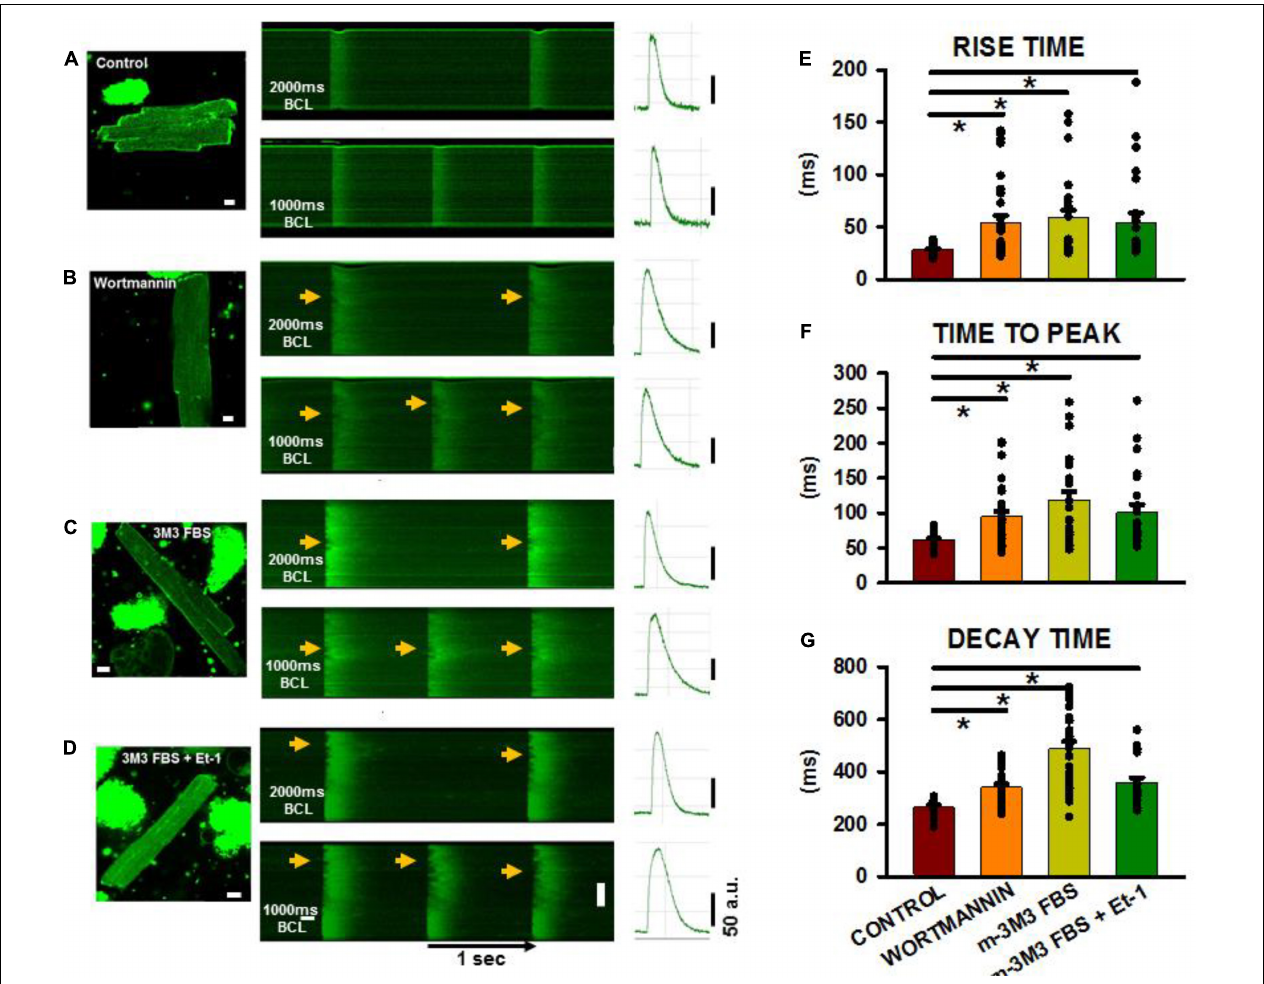
FIGURE 6 | Calcium transients in isolated adult ventricular myocytes after PIP2 depletion. (A–D) 2-D images with associated linescan images from treated and non-treated myocytes. Pacing was performed at basic cycle lengths of 2,000 and 1,000 ms. Arrows shows areas of delayed Ca 2 + release along the cell length in the myocytes. (E–G) Shows summaries of rise time, time to peak and decay time from control and treated cells at a pacing cycle length of 1,000 ms. Control ( n = 18–28 myocytes from 6 rats), wortmannin (27–36/5), m-3M3FBS (27/3), Et-1+m-3M3FBS ( n = 22–24/3). * p < 0.05 using a Dunn’s test following a one-way ANOVA performed on cells. Pixel size was 0.2 µ m with the pinhole adjusted to Airey units =